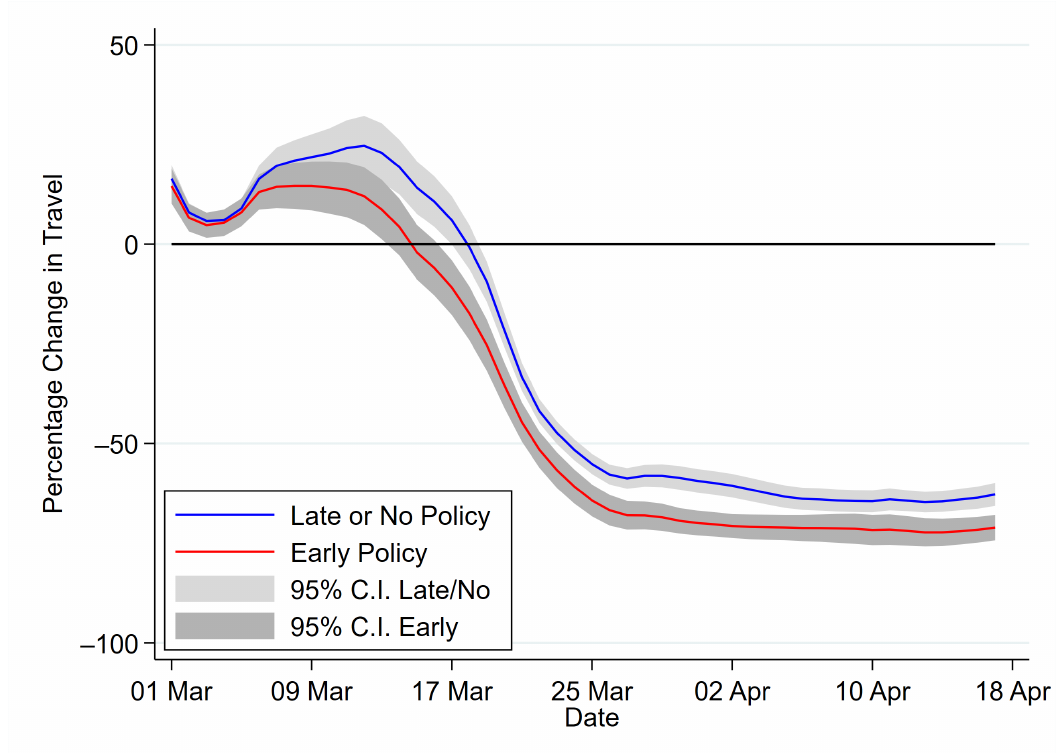
Figure A2. lReduction in StreetLight VMT travel data. Notes: Data from [36]. Baseline is average daily VMT in January 2020. Seven day moving averages. Early-policy states put a stay-at-home policy in place by 28 March 2020. Shaded area shows 95% confidence interval.